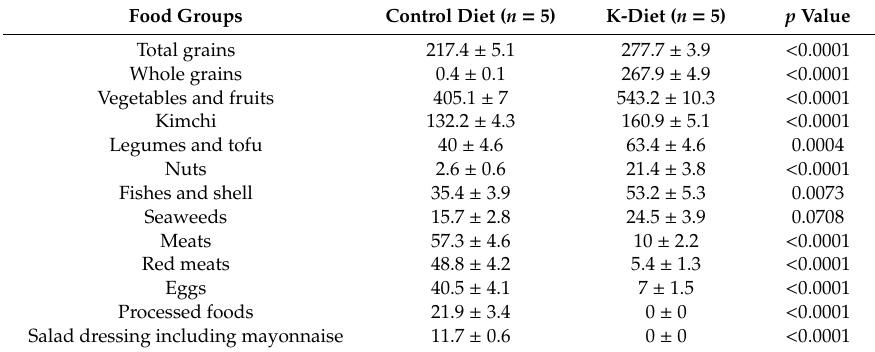
Table 4. Comparison of food consumption between the K-diet group and control (g /